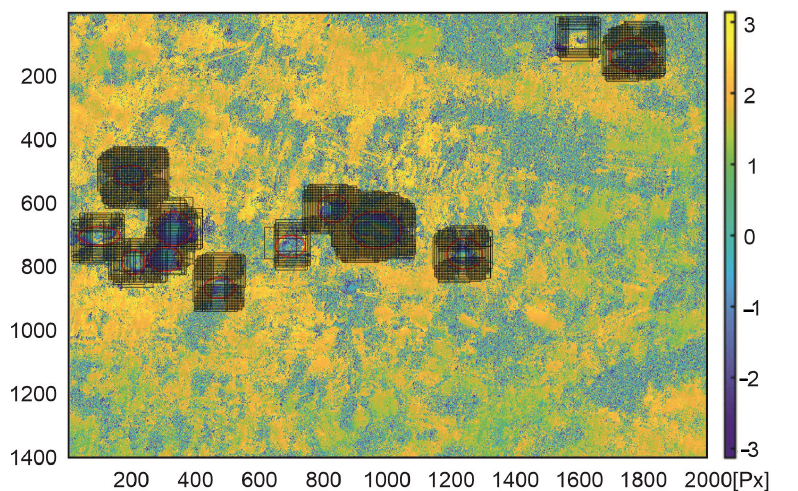
Figure 10. Interferogram of the first area computed from pictures recorded by Sentinel-1 on the 10th and 22nd of October 2016. Red ellipses are the subsidence area marked by experts; black squares were detected by the re-trained ResNet-50